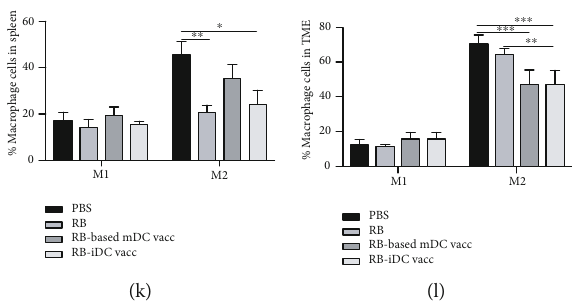
Figure 6: RB, RB-based mDC vaccine, and RB-iDC vaccine treatments led to tumour-speci fi c T cell responses, the induction of immune e ff ector cells and the attenuation of immunosuppressive cells in the LLC mouse model. (a, b) The CTL responses in the PBS-, RB-, RB- based mDC vaccine-, and RB-iDC vaccine-treated mice are shown. CTL responses were assessed in vitro using LLCs and Lewis CSCs as the target cells, respectively. The spleen was harvested at the end of the experiment. Splenic lymphocytes stimulated with RB-treated LLCs were used as the e ff ector cells. Three mice per group were analysed. (c, d) After restimulating the splenocytes with RB-treated LLC in vitro , the intracellular IFN- γ and TNF- α production of CD8 + T cells was measured by fl ow cytometry. PBS served as a control. The results are shown as the percentages of IFN- γ - and TNF- α -producing CD8 + T cells among the total CD8 + T cell population. (e) The percentages of Tem (CD8 + CD62L - CD44 + ), Tscm+Tn (CD8 + CD62L + CD44 - ), and Tcm (CD8 + CD62L + CD44 + ) cells are shown. (f) Ten days after therapy, the CD4 + T and CD8 + T cells of the splenic lymphocyte, tumour-in fi ltrating cell, and TDLN populations were analysed by fl ow cytometry ( n = 6 ). The data are representative of three independent experiments. (g, h) The Treg percentages. (i, j) The MDSC percentages. (k, l) The macrophage percentages in the TME and spleen are shown. Immune e ff ector cells and immunosuppressive cells were analysed by fl ow cytometry ( n = 5 ). The data are representative of three independent experiments. The mean ± SD are shown. Signi fi cance between samples was calculated by one-way ANOVA ( ∗ P < 0 : 05 , ∗∗ P < 0 : 01 , ∗∗∗ P < 0 : 001